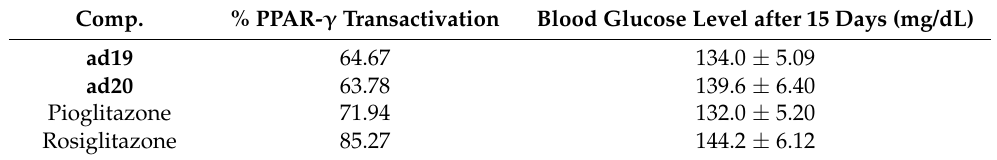
All data are given as mean ± SEM analyzed by one-way analysis of variance (ANOVA), using Dunnett’s multiple comparison test applied for statistical